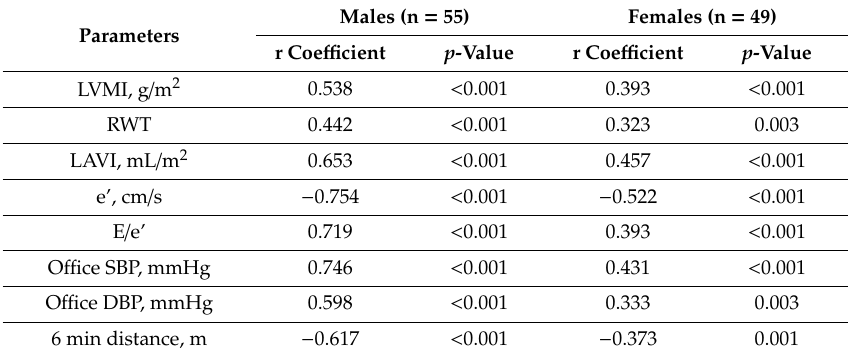
Table 3. Significant correlations of interleukin-6 blood level with other laboratory and instrumental indicators of cardiovascular prognosis in males and females with hypertension complicated by CHF with preserved left ventricle ejection